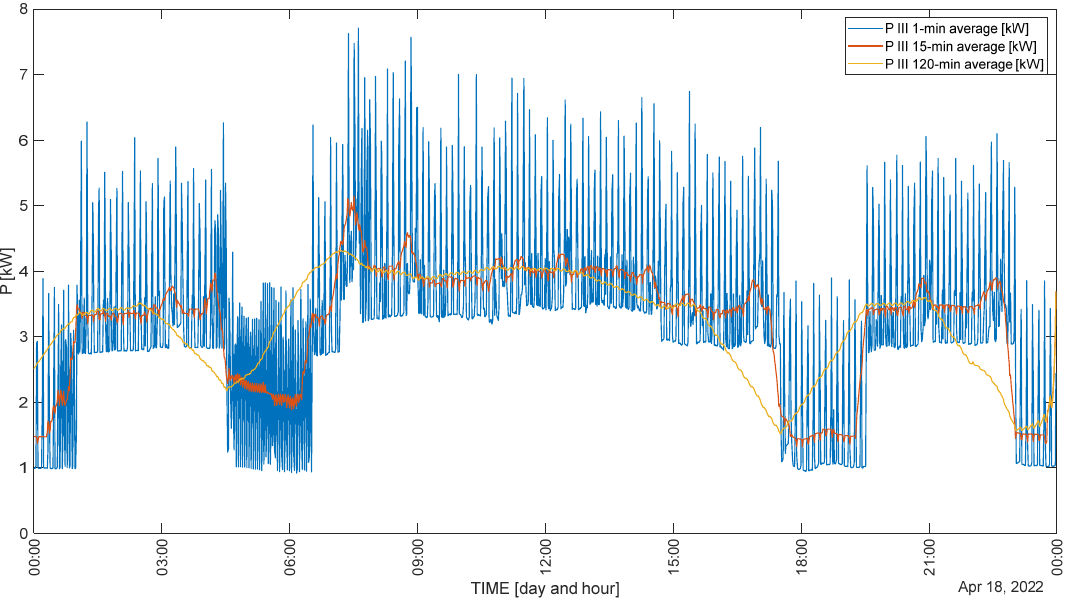
Figure 10. Three-phase active power as a function of time on a representative day of the 2nd stage.